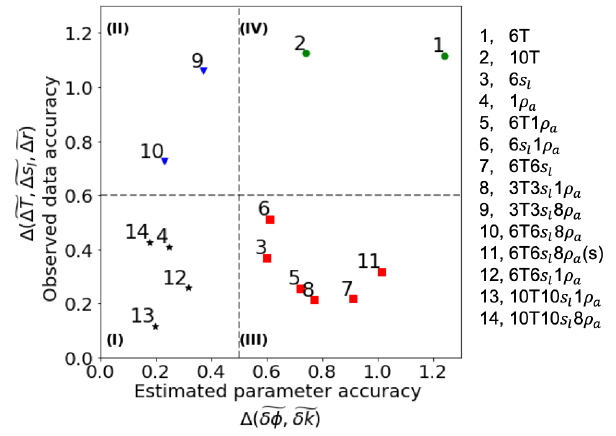
Figure 8. A k -means clustering analysis applied to the Euclidean norms of the normalized mean differences of estimated soil prop- erties and the corresponding fit between calculated and observed values. Each color and marker represent a certain class as a result of the k -means clustering